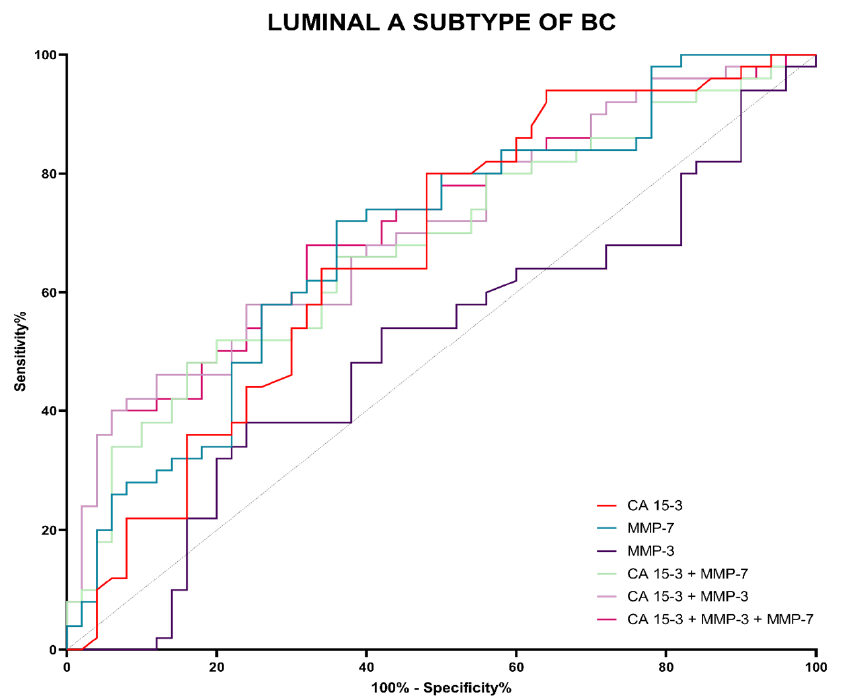
Figure 10. Evaluation of diagnostic power based on area under the ROC curve (AUC) in Luminal A subtype of BC.